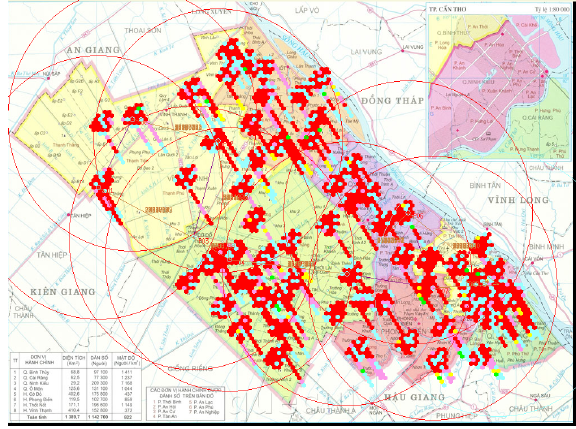
Figure 21. Hopperburnson the 13 th